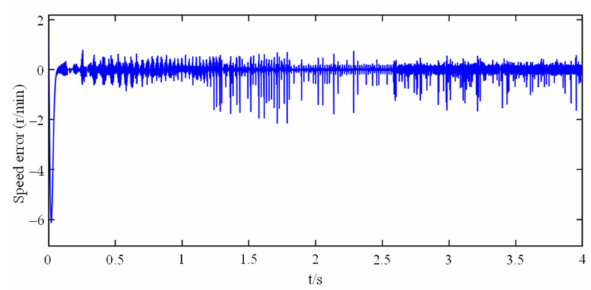
Figure 15. Rotation speed error waveform during acceleration process.